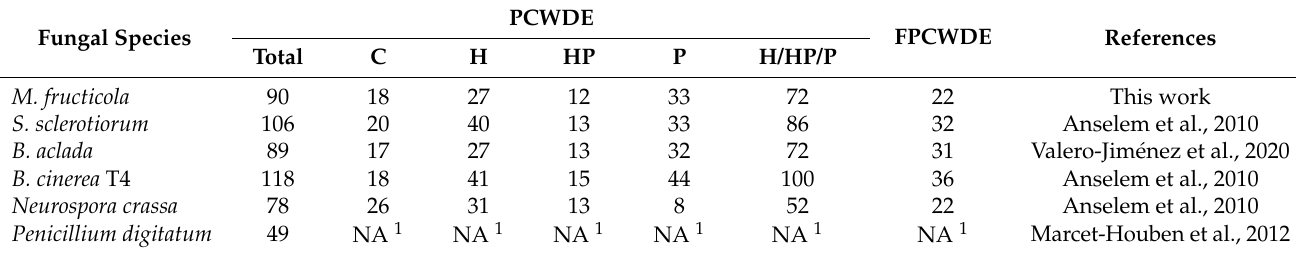
Table 2. Comparison of numbers of genes encoding plant cell wall degrading enzymes (PCWDE) and fungal and plant cell wall degrading enzymes (FPCWDE) in the genomes of Sclerotiniaceae species and other ascomycetes. The substrate preferences of the enzymes are provided for C (cellulose), H (hemicellulose), HP (hemicellulose or pectin side chains) and P (pectin).